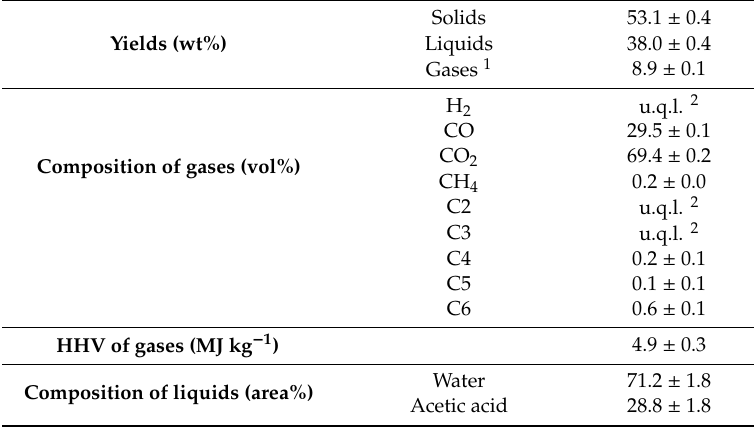
Table 1. Torrefaction yields and composition of gases and